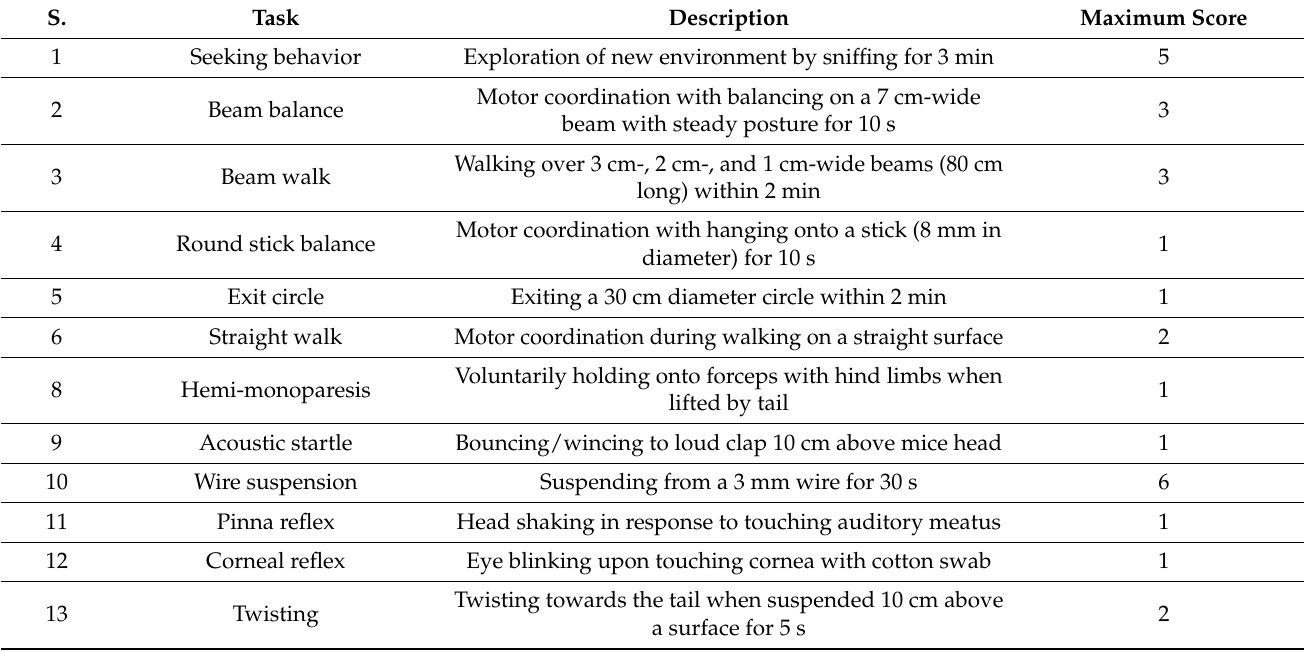
Table 1. Neurological severity score parameters and scoring